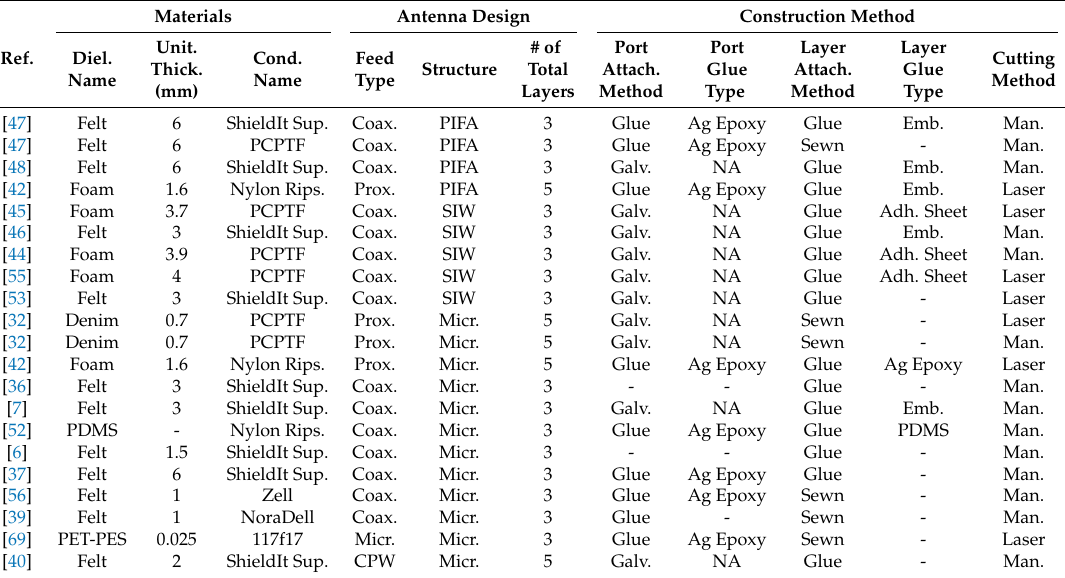
Table 2. Antenna Construction Techniques and